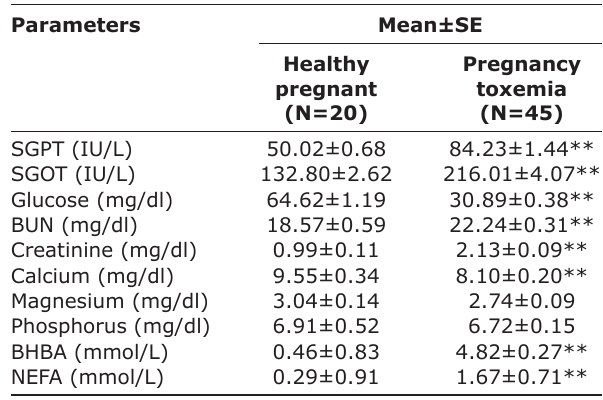
Table-3: Biochemical parameters of healthy pregnant and pregnancy toxemia affected